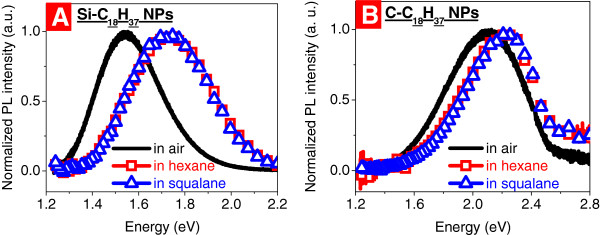
Room-temperature PL spectra of NPs in air and dispersed in hexane and squalane. Si-C18H37 (A) and C-C18H37 (B) NPs. Excitation energy of 2.54 eV (A) and 3.62 eV (B).